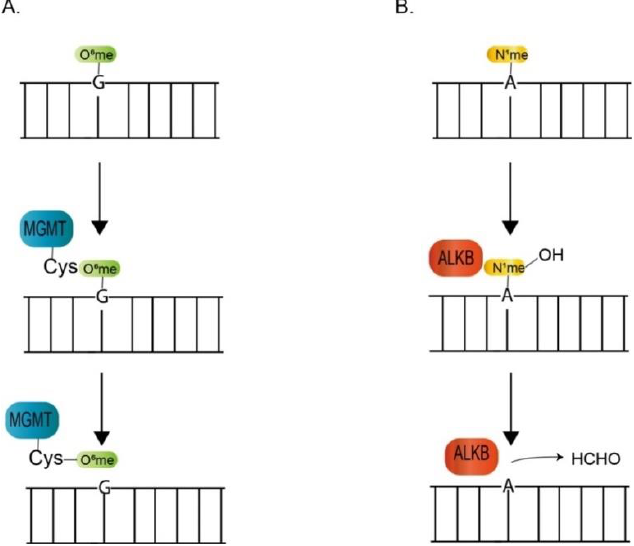
Figure 2. Diagrammatic summary of dinoflagellate orthologues in the direct reversal of DNA damage pathway. ( A ) Repair of O 6 -methylguanine by the MGMT protein. ( B ) Repair of N 1 -methyladenine and N 3 -methylcytosine by ALKB protein. Only N 1 -methyladenine is represented.